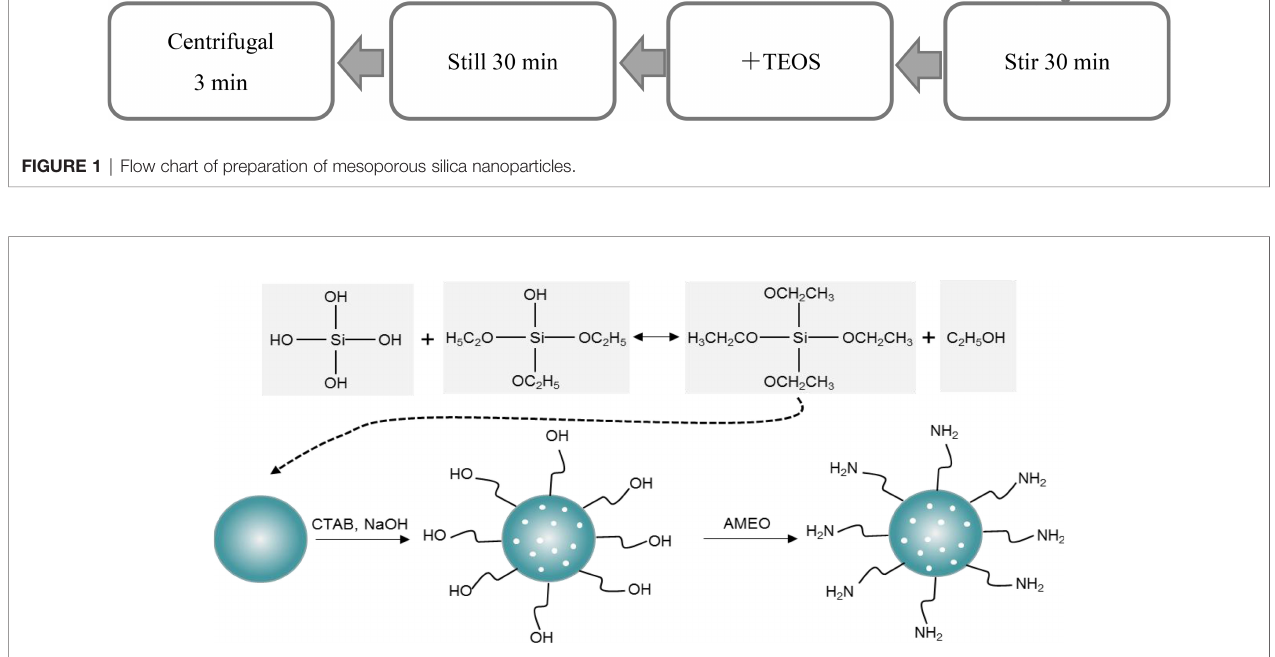
FIGURE 2 | MSN surface amine process.